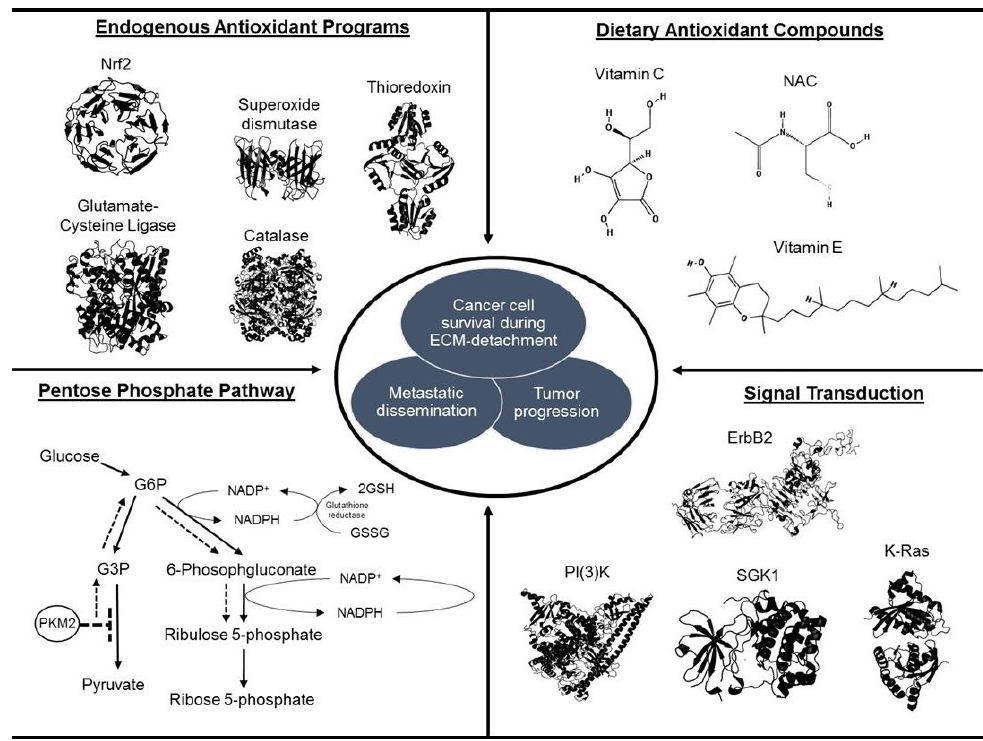
Figure 1. Mechanisms of antioxidant generation during cancer development. A wide variety of endogenous antioxidant pathways exist within cells which mitigate oxidative stress to enhance cell survival. The above pathways are paramount to augment survival in the absence of matrix attachment, tumor progression, and metastatic dissemination. All protein structures were retrieved from the RSCB Protein Data Bank [30] and compounds were retrieved from PubChem